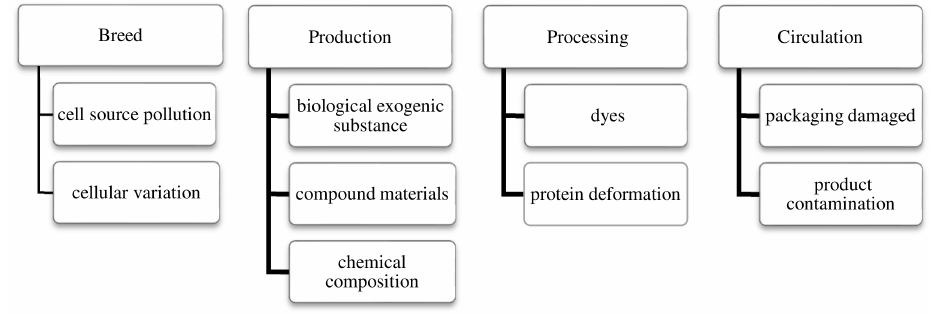
Figure 2. Hazards affecting quality and safety of CM